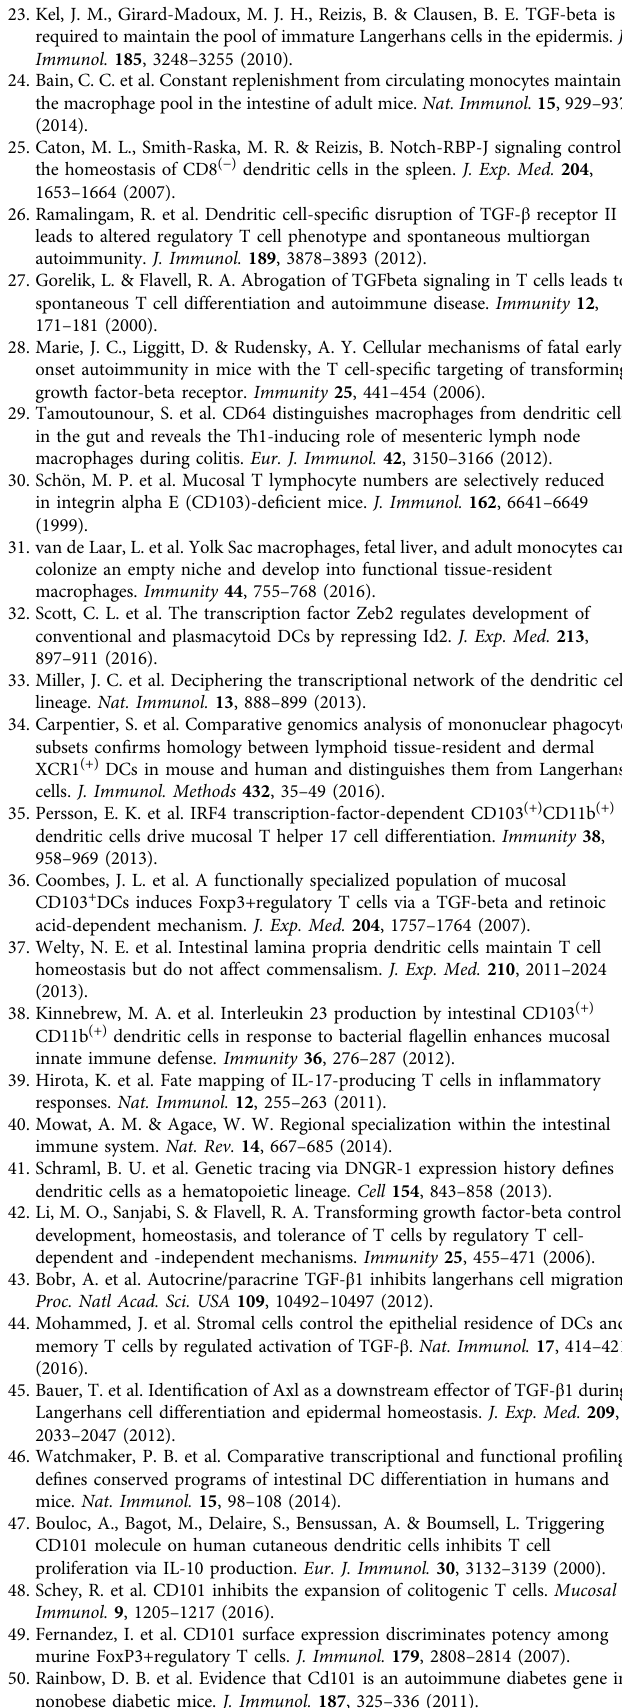
Statistics . Statistical analyses were performed with GraphPad Prism. Student ’ s t -test was used to compare two groups, while multiple groups were compared using analysis of variance or Student ’ s t -tests with appropriate corrections as detailed in the legends. A p -value of 0.05 was considered signi fi cant.